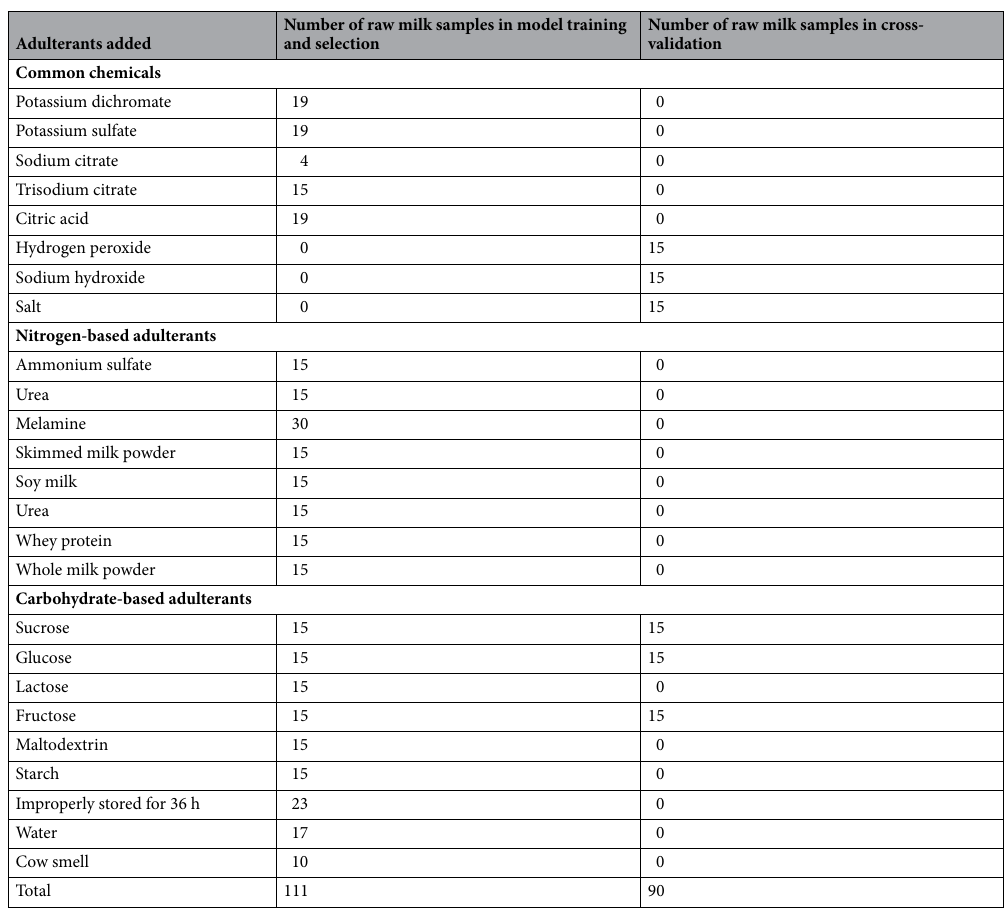
Table 5. Number of spiked samples in 1) model training and selection, 2) cross-validation. All samples were spiked with adulterants with concentrations 0.01, 0.02, 0.05, 0.1, 0.2 g per 100 g raw milk.